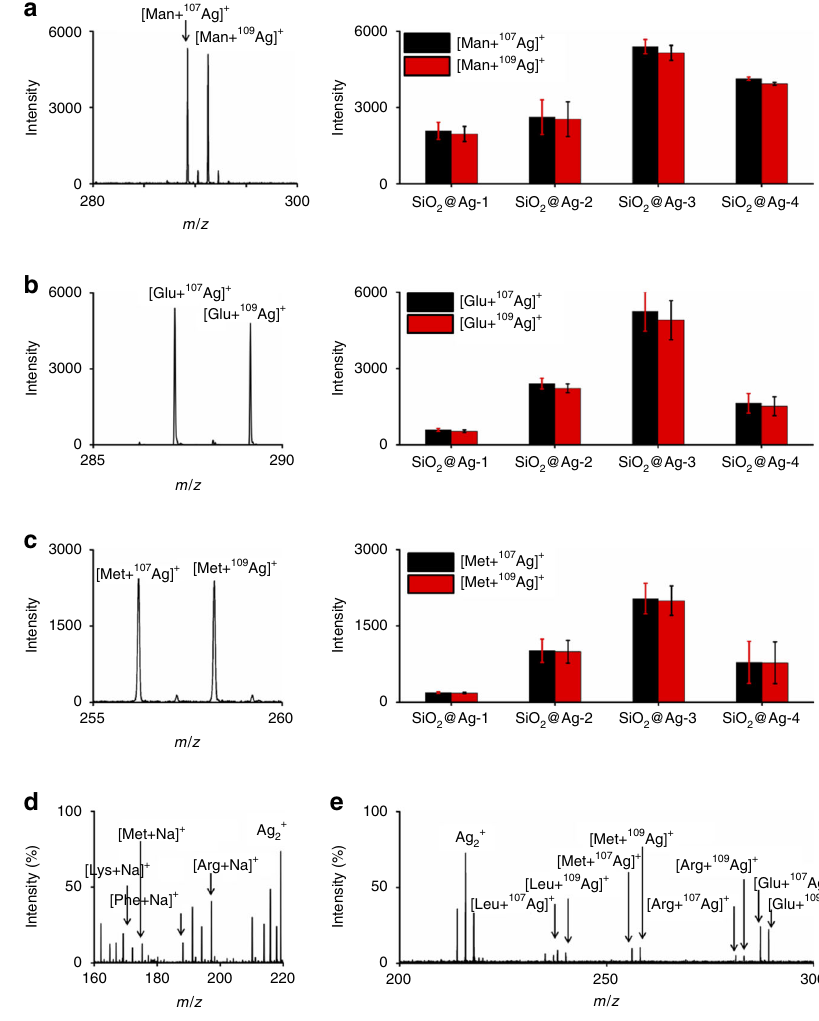
Fig. 2 Selection of optimized SiO 2 @Ag. LDI MS analysis of 10 ng μ L − 1 a mannitol, b glucose, and c methionine in the positive ion mode using SiO 2 @Ag-1, SiO 2 @Ag-2, SiO 2 @Ag-3, and SiO 2 @Ag-4 as matrices, including typical mass spectra showing silver-adducted molecular peaks of theses metabolites and mean intensities of signals obtained using different SiO 2 @Ag particles as matrices. The error bars were calculated as s.d. of three measurements ( p < 0.05, one-sided t -tests). Mass spectra of d 2 nM lysine, methionine, arginine, and phenylalanine in 0.5 M NaCl and e 2 nM leucine, methionine, arginine, and glucose in 5 mg mL − 1 bovine serum albumin solution with a KCl concentration of 0.5